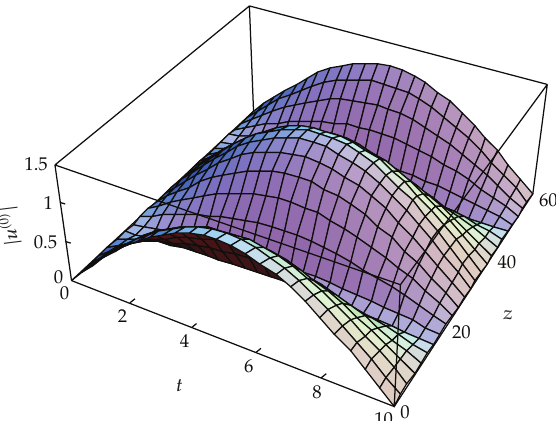
Figure 31: The zero-order approximation of | u (cid:3) 0 (cid:4) | at α (cid:8) 1, T (cid:8) 10, γ (cid:8) 0 with considering only one term in the series (cid:3) M (cid:8) 1 (cid:4) .